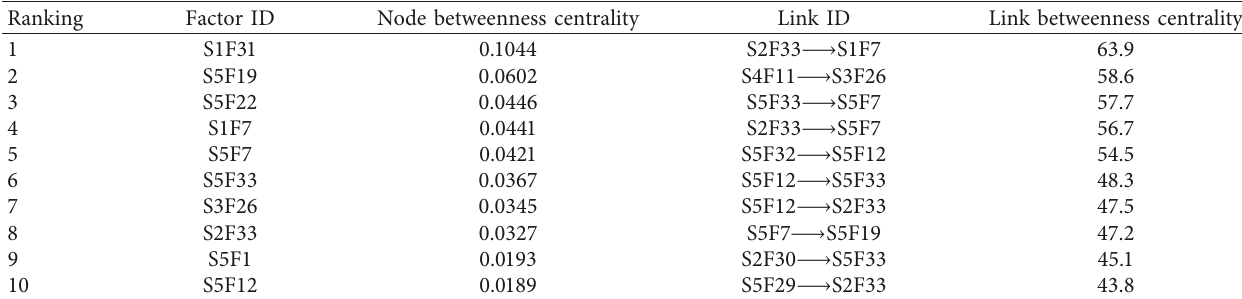
Table 4: Critical factors and links for BIM adoption in SMEs based on betweenness centrality.